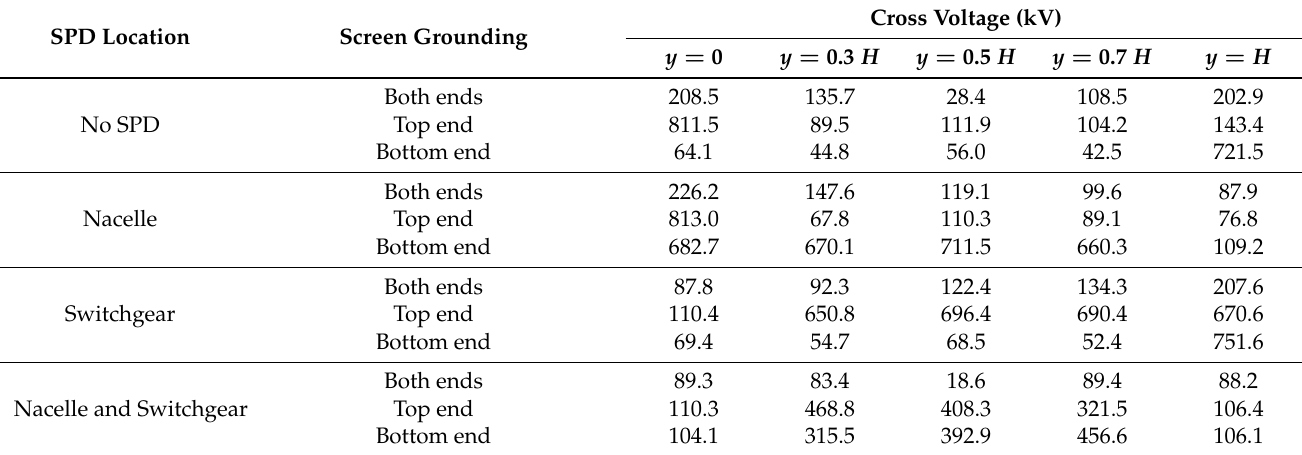
Figure 9. Overvoltage amplitudes distribution across the power cable with 12 kA and 1/75 µ s. Table 2. Cable cross voltages as a function of the screen grounding practice and SPD